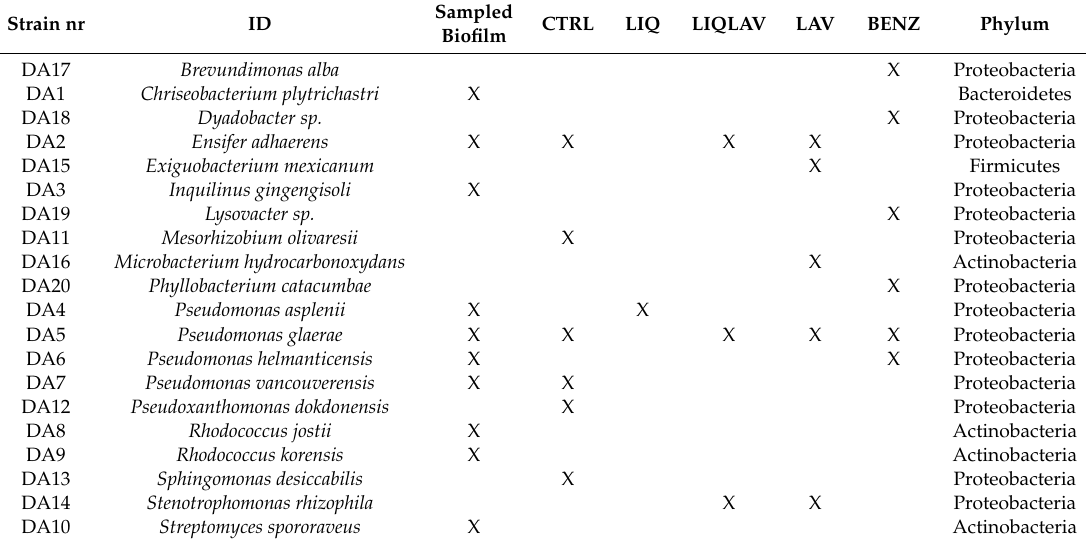
Table 3. Phylogenetic identification by 16S r-DNA sequencing of the bacterial strains from the sampled biofilm (in situ) and from the di ff erent treatments after the second application. The X indicates the occurrence of each strain in the di ff erent